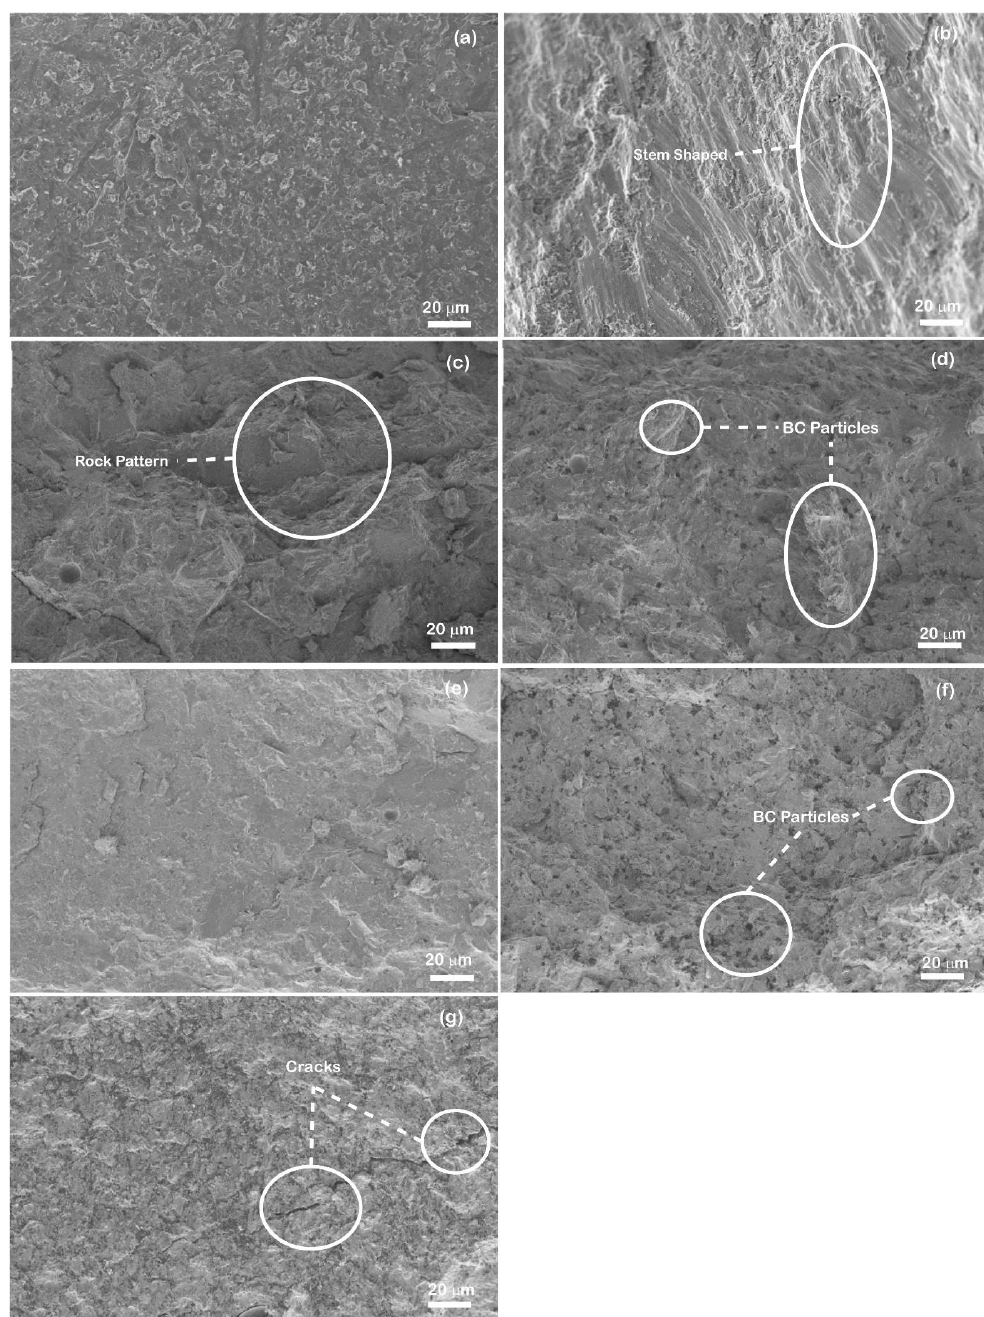
Figure 15. The fracture structure of various B 4 C/Ni63 coatings below 1000 × ( a ) 10% B 4 C, ( b ) 15% BC, ( c ) 20% B 4 C, ( d ) 25% B 4 C, ( e ) 30% B 4 C, ( f ) 35% B 4 C, ( g ) 40% B 4 C.